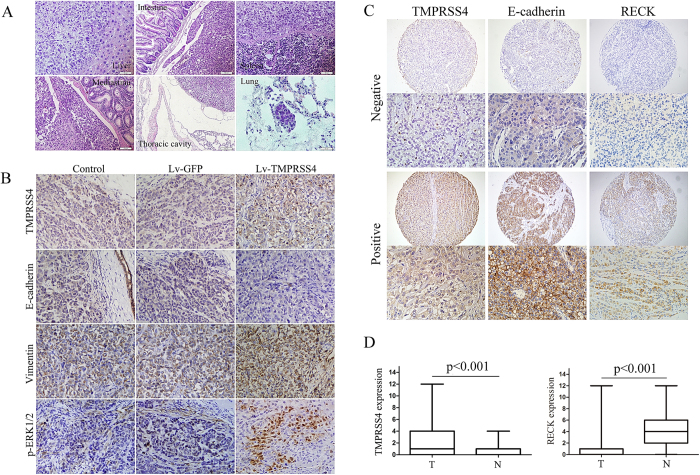
A HE stain of TMPRSS4 overexpression tumors that metastasize to live, intestinal mesentery, spleen, mediastinu, thoracic cavity and lung; B Immunohistochemical assay of tumors in mice of the control group, Lv-GFP group and Lv-TMPRSS4 group revealed that E-cadherin expression was significantly reduced while the expression of vimentin and activity of ERK1/2 was greatly enhanced in tumors overexpressing TMPRSS4; C Positive and negative expression of TMPRSS4, E-cadherin and RECK in human HCC samples by using human tissue microarray; DBox-and-whisker plots of the staining. The immunoreactive score of human HCC (T) and adjacent nontumor tissues (N) is shown as mean ± SD.